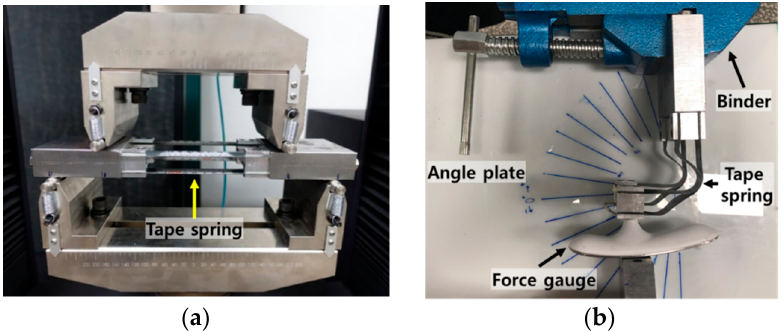
Figure 3. Test configuration for measurement of the moment – rotation profile: ( a ) four-point bending test for small angles, ( b ) push-pull test for large angles.